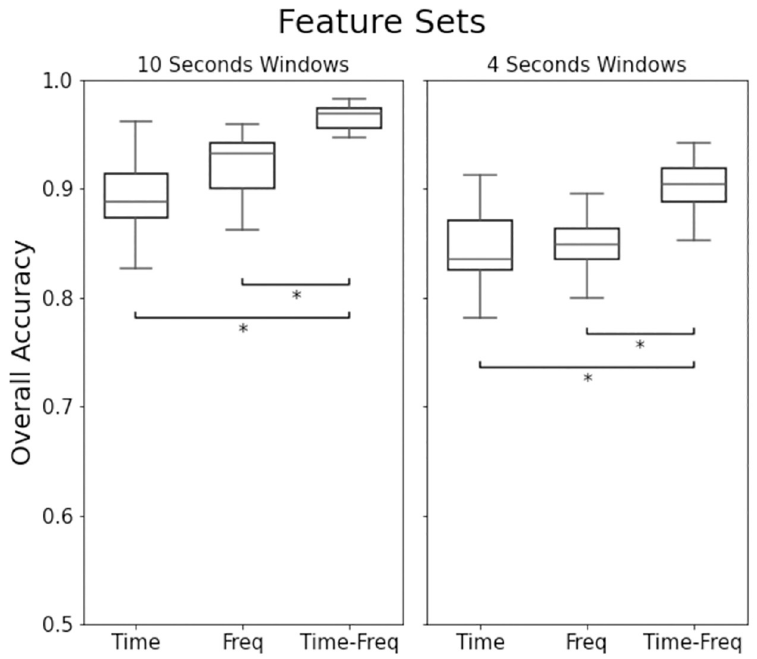
Fig 5. Inter-subject overall accuracy’s for the feature sets, presented separately for each window length. The � indicates statistically significant difference (p < 0.05) between pairs.